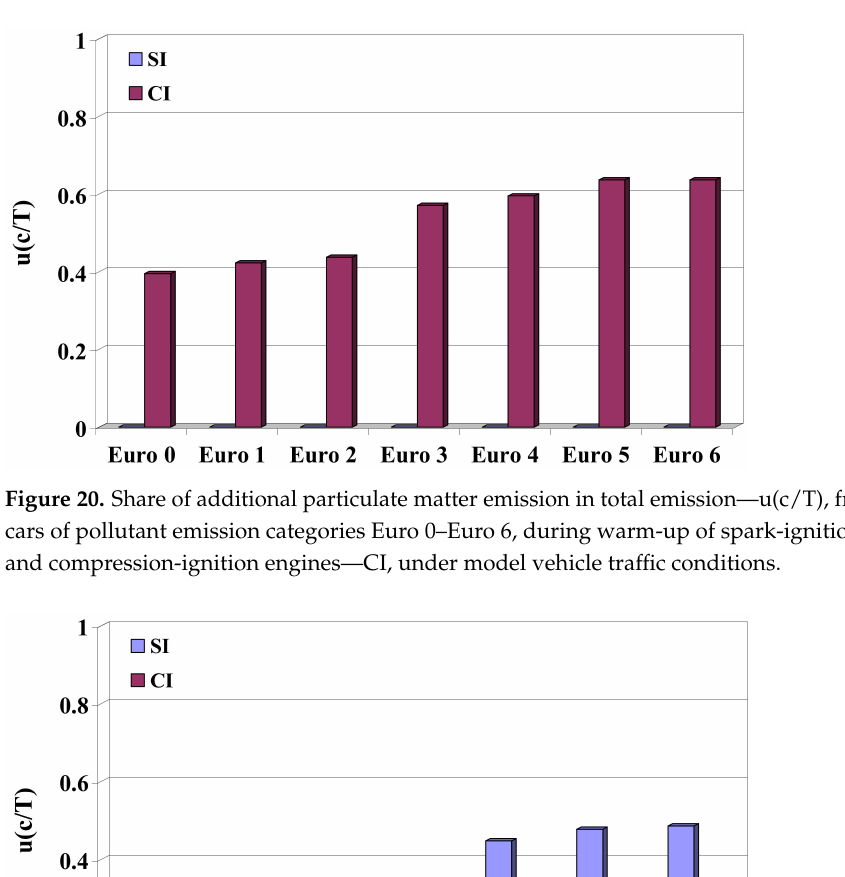
Figure 19. Share of additional nitrogen oxides emission in total emission—u(c/T), from passenger cars of pollutant emission categories Euro 0–Euro 6, during warm-up of spark-ignition engines—SI and compression-ignition engines—CI, under model vehicle traffic conditions.